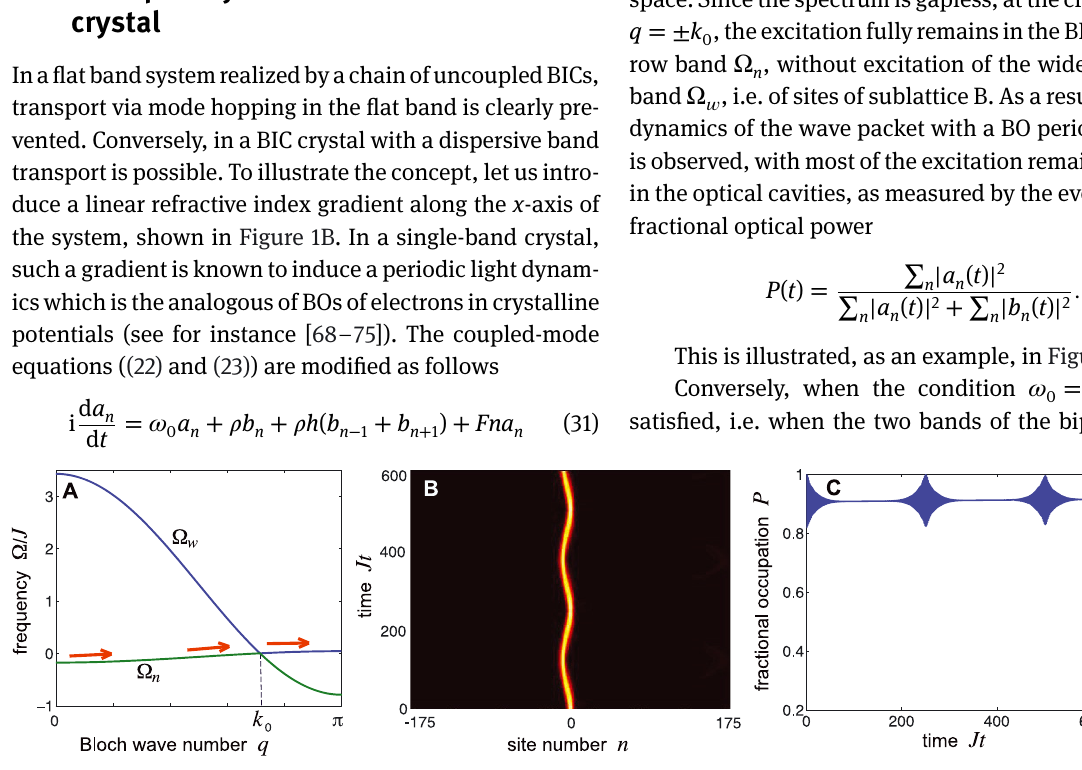
] with initial wave number q = 0 and width 𝑤 = 3. The (0) = exp [− ( n ∕ 𝑤 ) 2 + i q 0 n 0 n + Ft , which is schematically depicted in (A) by solid 0 , the wideband Ω 𝑤 is not excited and the entire wave packet undergoes a 0 = 2 π∕ F ≃ 251 . 3 ∕ J . This is shown in panel (B), which , with a period T B n ( t ) | in the various cavities, labeled by the site number n . The n